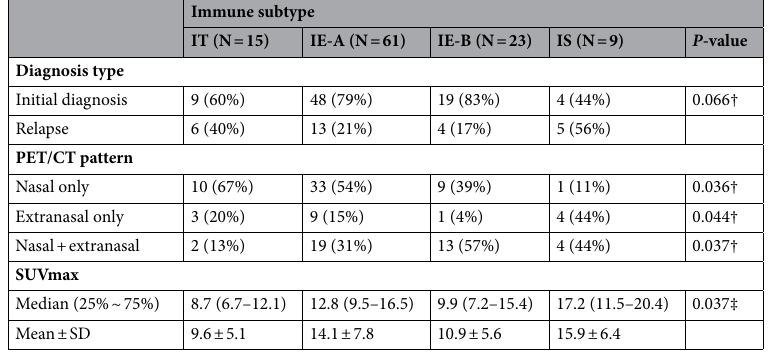
Table 2. FDG PET/CT pattern according to immune subtype. IT, immune tolerance; IE, immune evasion; IS, immune silenced; SUV, maximum standardized uptake value; SD, standard deviation; †, Chi-squared test ; ‡ Kruskall-Wallis test.